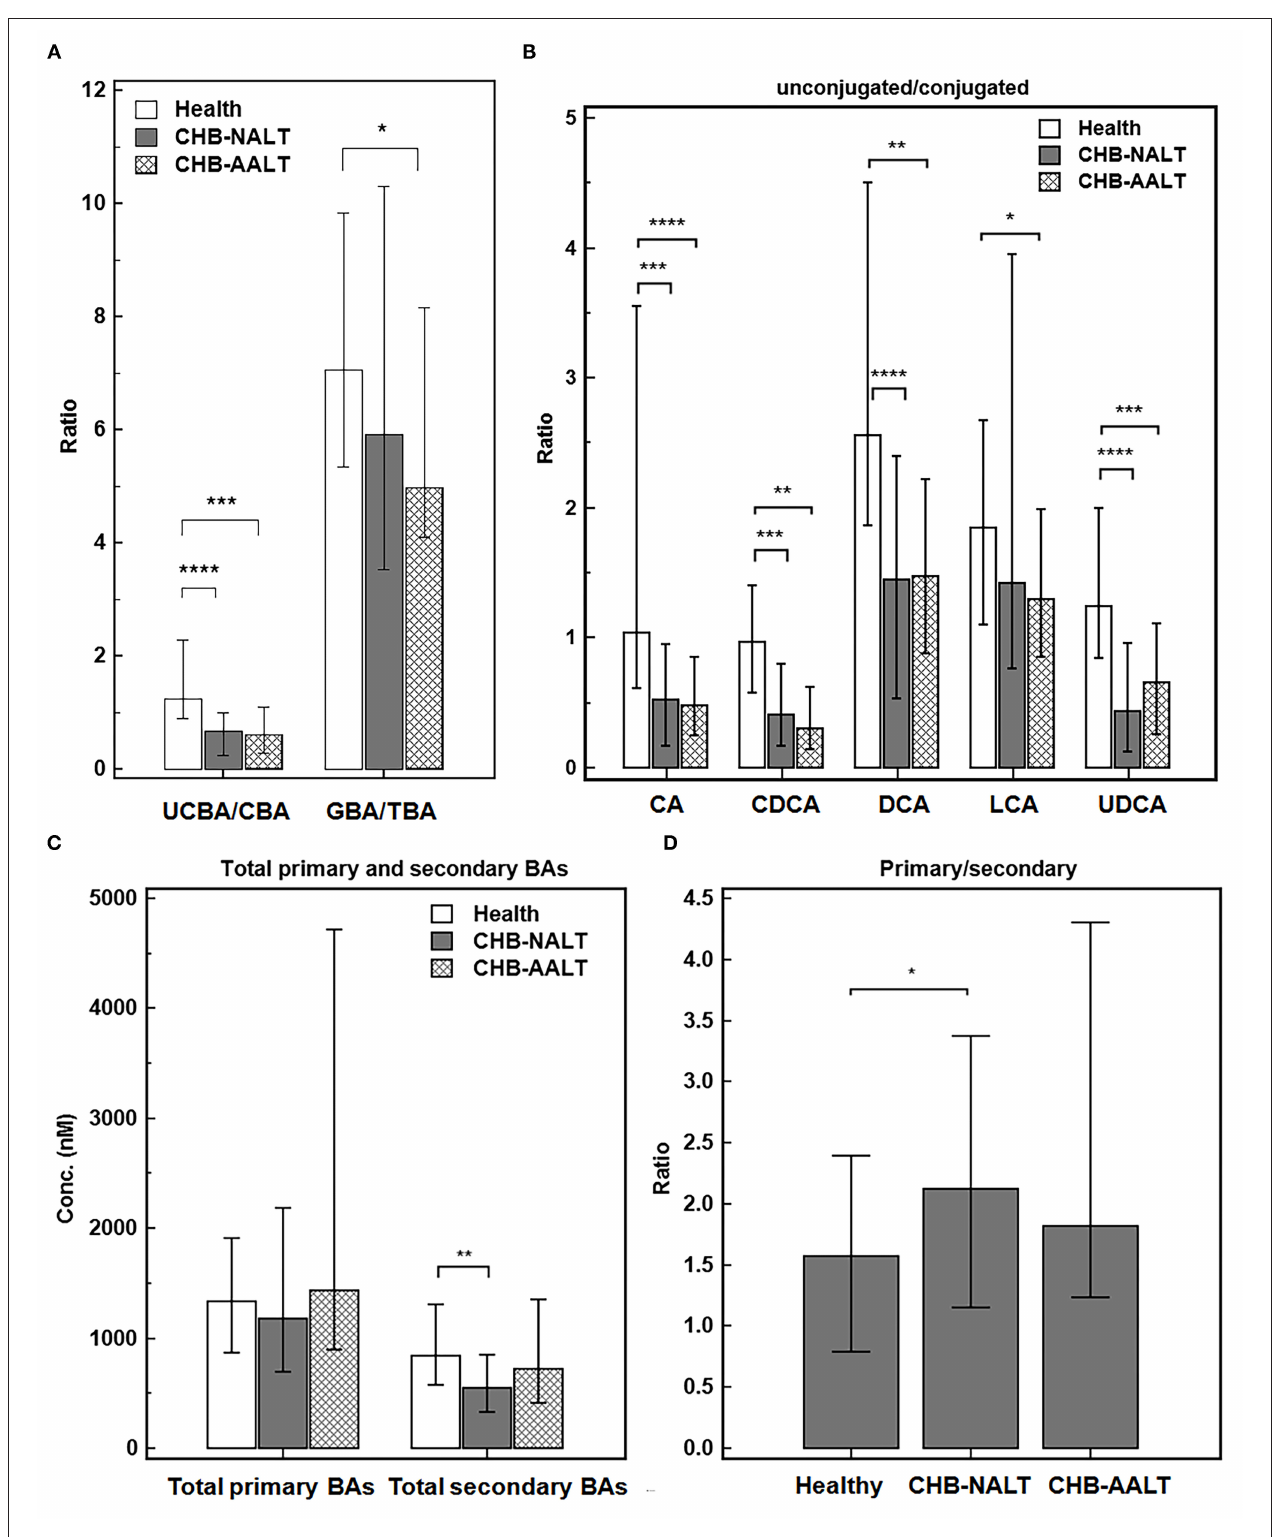
FIGURE 2 | Alteration of BA ratios in CHB patients. The ratios of (A) total unconjugated BAs vs. total conjugated BAs, and total glyco-conjugated vs. total taurine-conjugated BAs, (B) ratios of unconjugated vs. conjugated individual BAs, (C) total primary BAs vs. secondary BAs levels and (D) ratios of total primary BAs vs. secondary BAs across all three groups were summarized. Error bars represented 25–75% quartile. P values were determined by the Mann–Whitney U test, significant differences were noted by * p < 0.05, ** p < 0.01, *** p < 0.001, **** p < 0.0001. CHB-NALT: ALT normal patient group, CHB-AALT: ALT abnormal patient group.